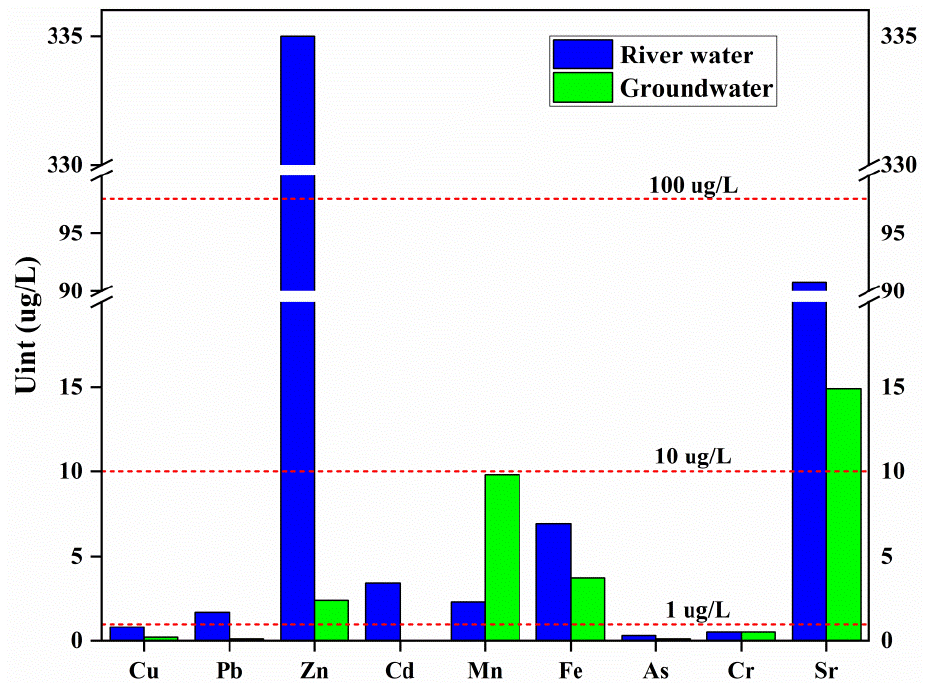
Figure 2. The median concentrations of dissolved heavy metals in the Sidi River’s basin.